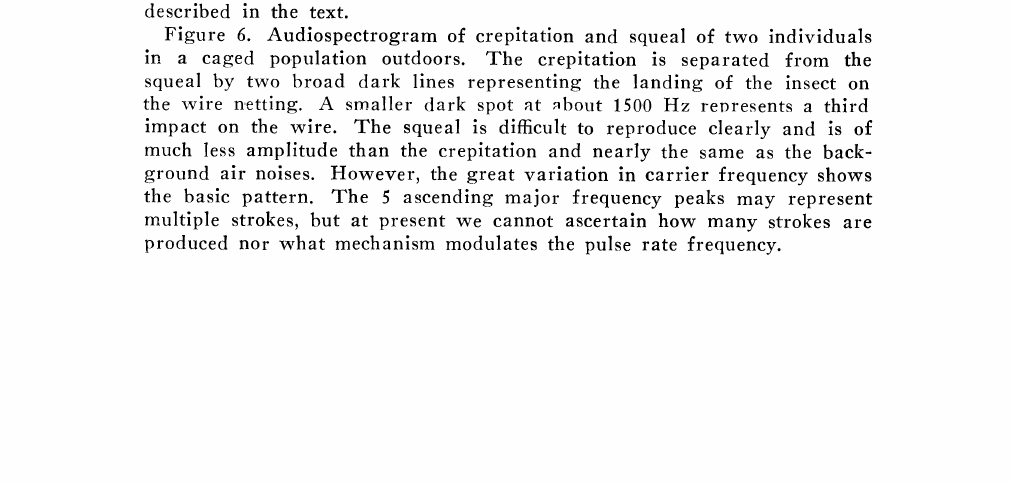
Figure 5. Audiospectrogram of chipmunk (Eutamias sp.) alarm cry. The fundamental frequency of this complex sound seems to be to. 8 KHz which to human ears would average a high grasshopper chirp of KHz. Since grasshoppers probably are tone deaf, the amplitude (at greater distance), great directionality of the sound, its duration, and spacing could be a good mimic of the chirp, thus causing the orientation of the two males described in the text. Figure 6. Audiospeetrogram of crepitation and squeal of two individuals in a caged population outdoors. The erepitatio.n is separated from the squeal by two broad dark lines representing the landing of the insect on the wire n.etting. A smaller dark spot at about 150’0 Hz reresents a third impact on the wire. The squeal is difficult to reproduce clearly and is of much less amplitude than the crepitation and nearly the same as the back- ground air noises. However, the great variation in carrier frequency shows the basic pattern. The ascending major frequency peaks may represent multiple strokes, but at present we cannot ascertain how many strokes are produced nor what mechanism modulates the pulse rate